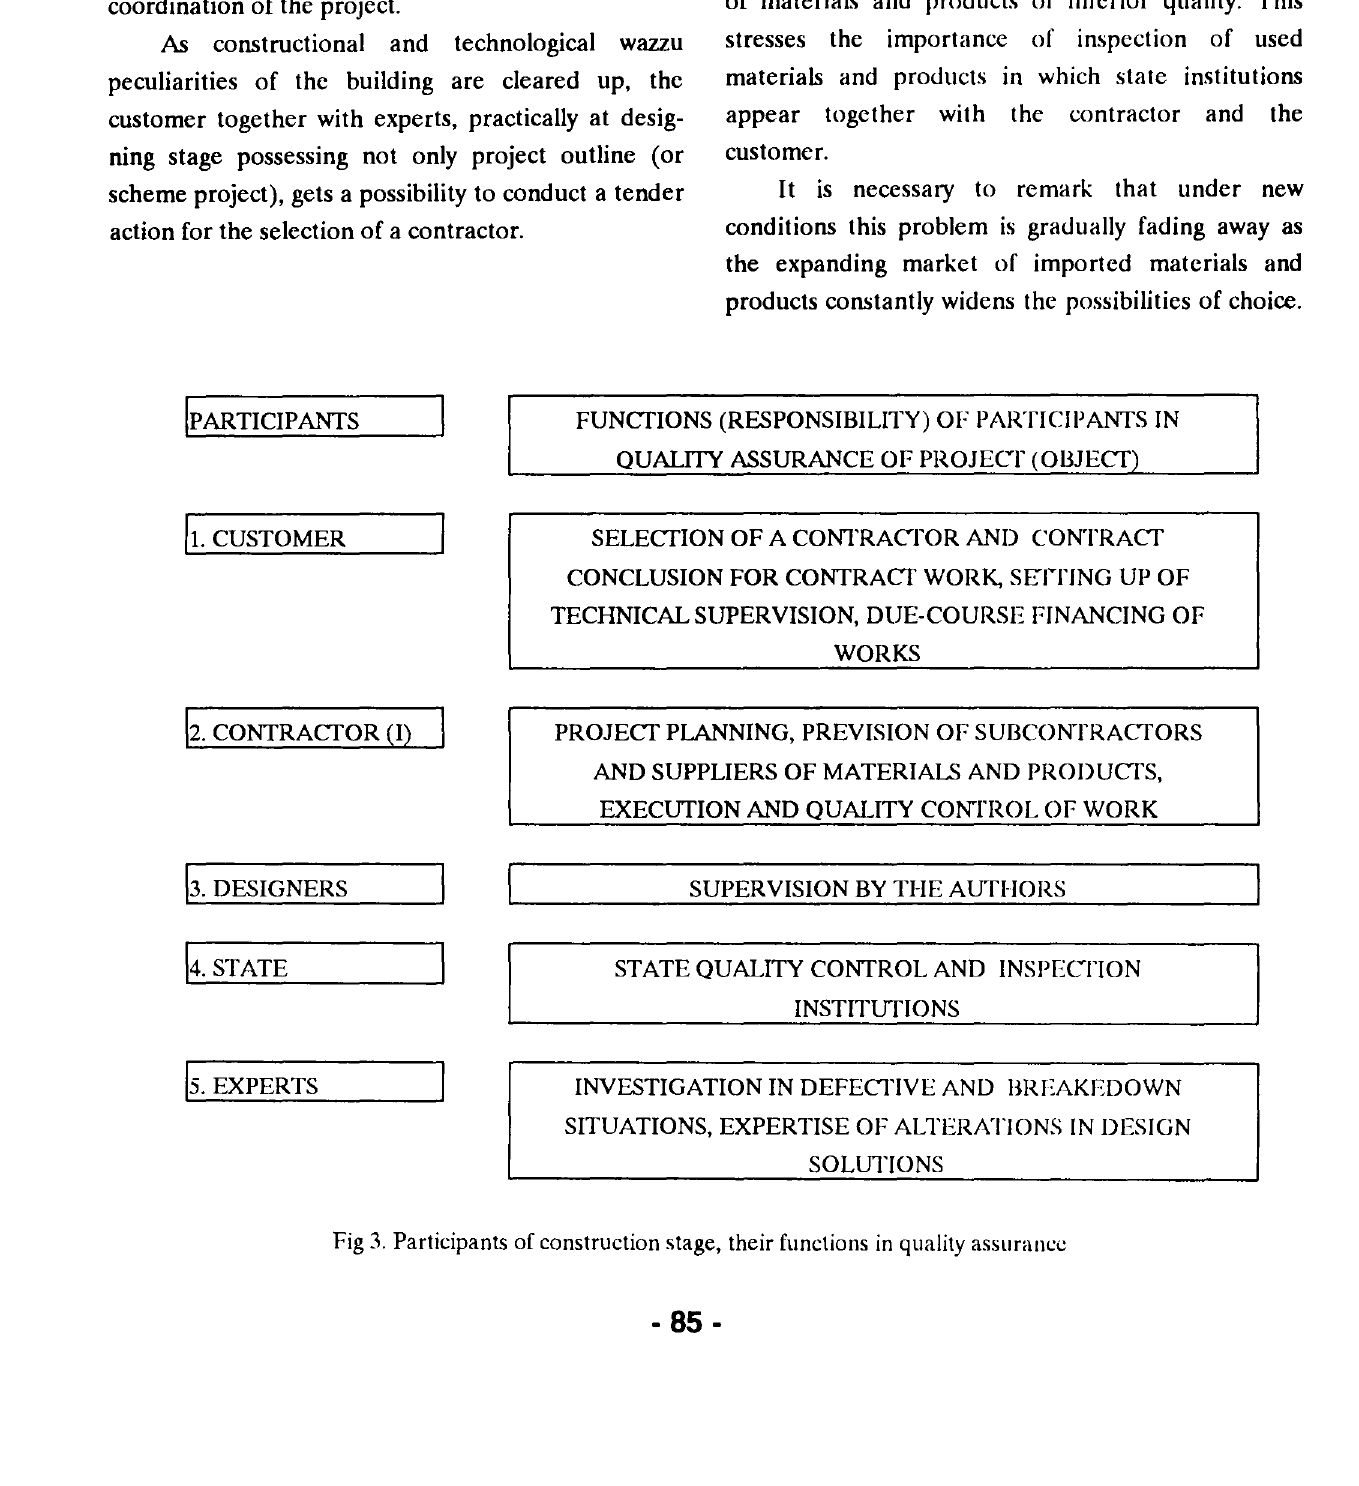
Fig 3. Participants of construction stage, their functions in quality assurance •